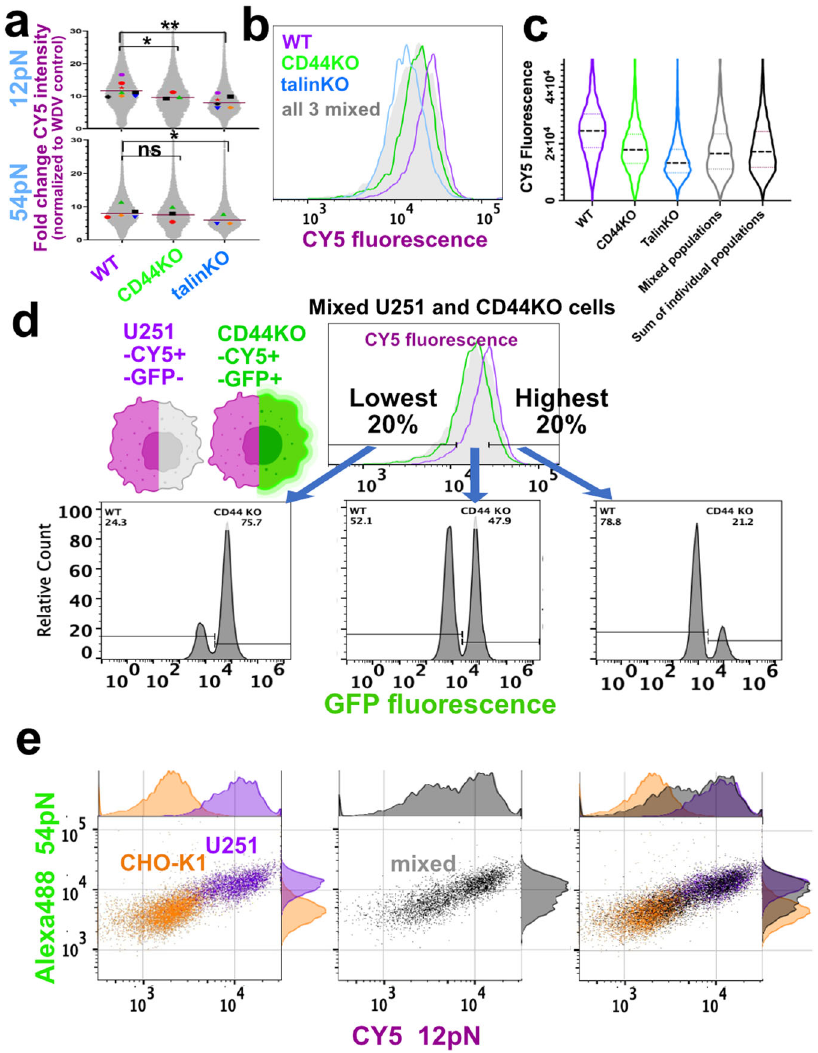
Fig. 3 | RAD-TGTs detect CRISPR-KO ofmechanosensing proteins in single and mixed cell populations. a SuperPlots of the fold change of CY5 fl uorescence intensityofindividualWT,TLN1KO,orCD44KOU251cellson12pN(top)or54pN (bottom)RAD-TGTswithWDV-Echi.SymbolsrepresentthemedianCy5foldchange for each replicate experiment. Identical symbols indicate the samples were col- lected on the same day. The horizontal red line isatthe medianfold change for all cells analyzed. For 12 pN experiments, n =8 (WT), 3 (CD44KO), or 6 (talinKO) and for 54 pN experiments n =5(WT) and 3 (CD44KO and talinKO). A two-tailed paired t -test was used for statistics, * p =0.0360 (12 pN CD44KO), ** p =0.0028 (12 pN talinKO), and * p =0.0322 (54 pN talinKO). Medians were paired based on the day each experiment was performed. b Histogram of a mixed population of U251 WT,